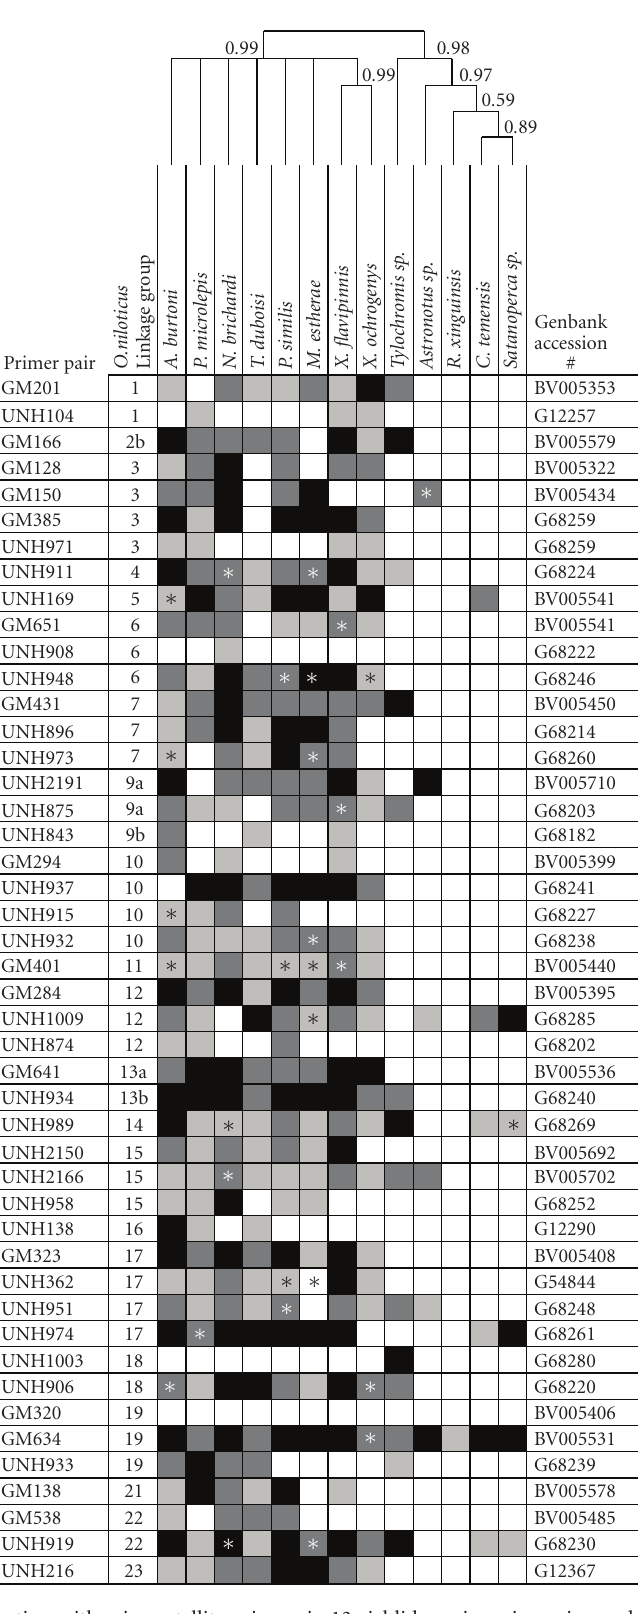
Figure 1: Successful PCR amplification with microsatellite primers in 13 cichlid species using primers designed to Tilapia. Color indicates relative intensity of the PCR band black: brightest, dark grey: visible, light grey: faint, white: absent. Definitive doublets are indicated with an asterisk. The dendrogram represents the consensus cluster confidence values indicated based upon 1000 trees, with resampling, using presence or absence of product and Euclidean distance